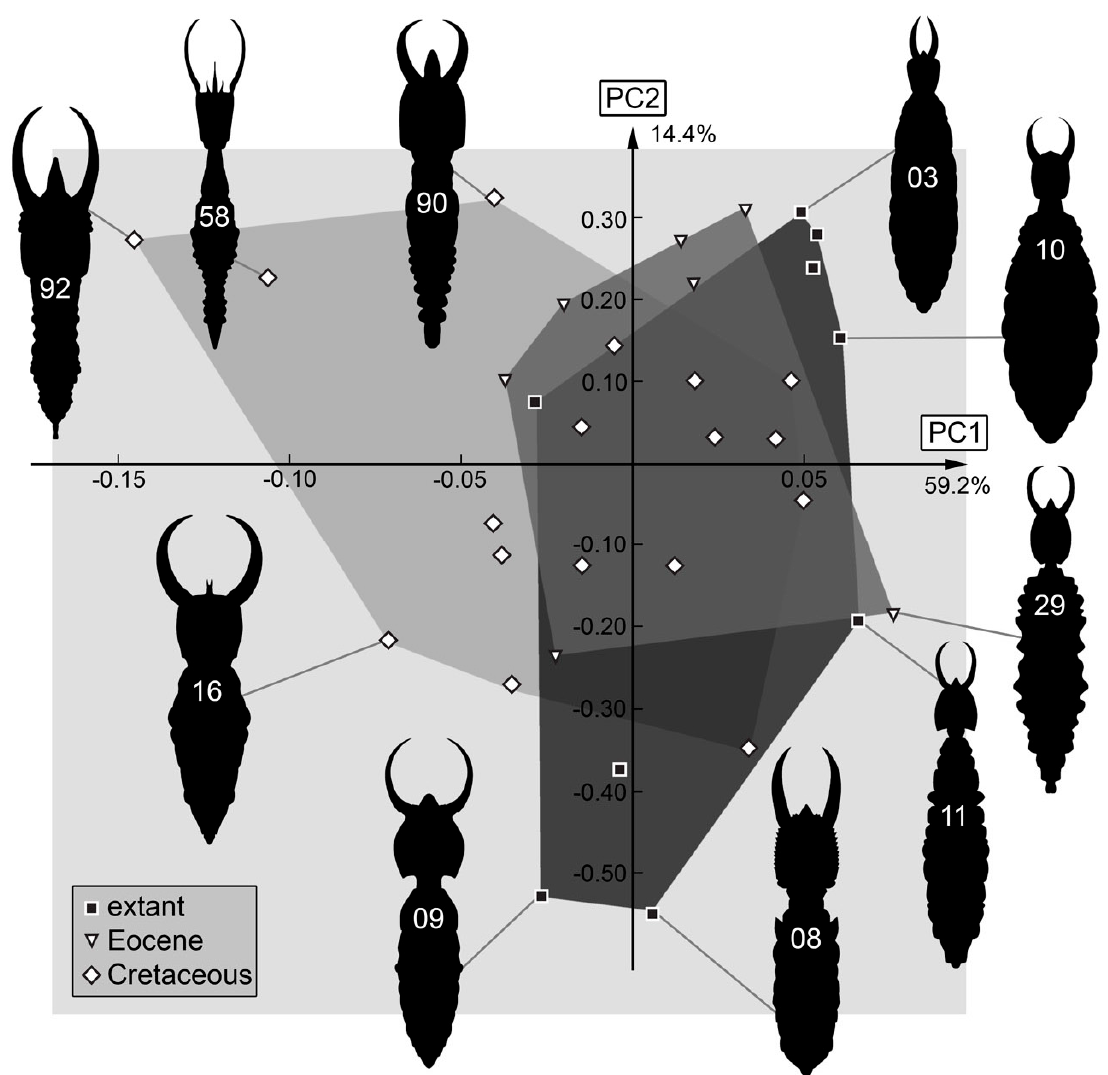
Figure 35. Scatterplot of PC2 vs. PC1 values of body + stylet shapes (see Supplementary Materials File S2 for details).